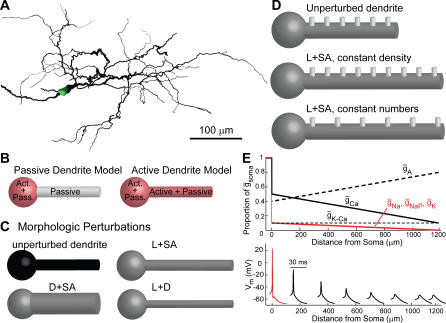
Constructing the Morphologic Model(A) Morphology of an Area II neuron traced in 3-D. The reduced morphology in (B) conserved the surface area of the soma (shown in green) and the length and surface area of the dendritic tree. The axon (truncated thick process extending from the left of the soma) was omitted.(B) Channel distributions in active and passive dendrite models. Red compartments included active channels; gray compartments included only passive ones.(C) Morphologic perturbations. Top left: unperturbed model morphology. Top right, L + SA: dendritic length L and surface area SA perturbed with dendritic diameter D held constant. Bottom left, D + SA: D and SA perturbed with L held constant. Bottom right, L + D: L increased and D decreased such that SA remained constant.(D) When dendritic morphology of the active dendrite was perturbed (e.g., L + SA), either the original dendritic channel density of each ion species was conserved (constant density; middle) or the number of dendritic channels was conserved (constant numbers; bottom).(E) Top, spatial distribution of active channels in the active dendrite. Dendritic channel density (as a proportion of its somatic density) either increased (
, thick dashed line), decreased (
, solid black line;
,
,
, red solid line), or remained constant (
, thin dashed line). See Materials and Methods. Bottom, decremental AP backpropagation as a function of distance from the soma, for the conductance distributions shown at top. Somatic AP shown in red.